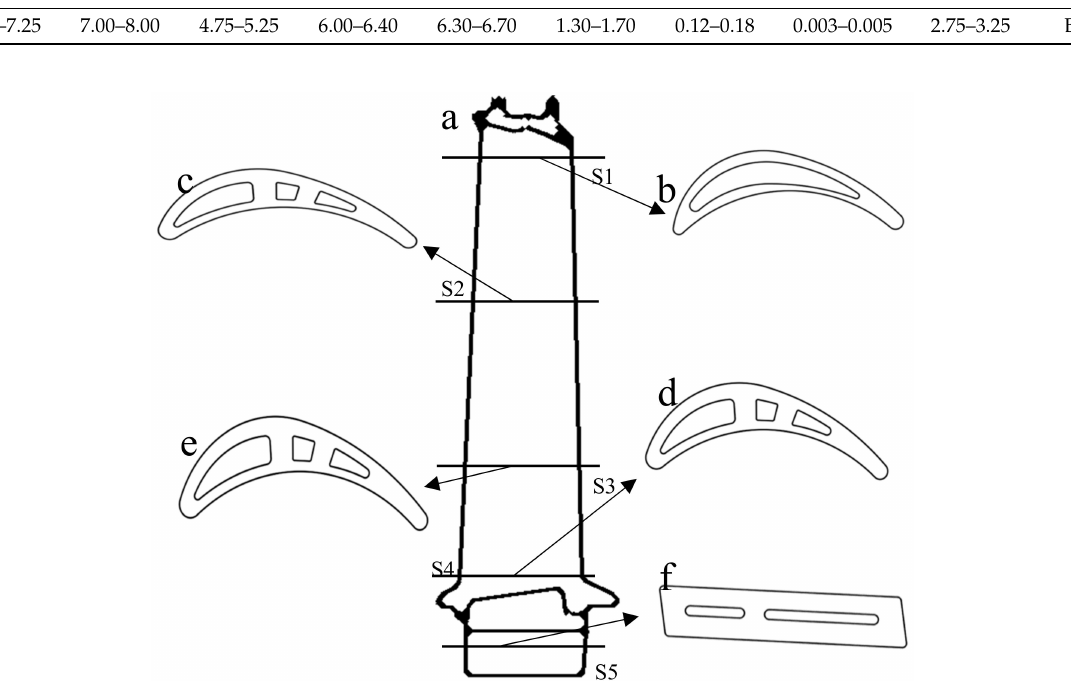
Figure 1. Schematic diagrams of typical sectional positions of the single crystal blade. ( a ) Single crystal superalloy blades and selected sectional positions, S1–S5, are the selected sectional positions; ( b – f ) are the corresponding sections of S1–S5,